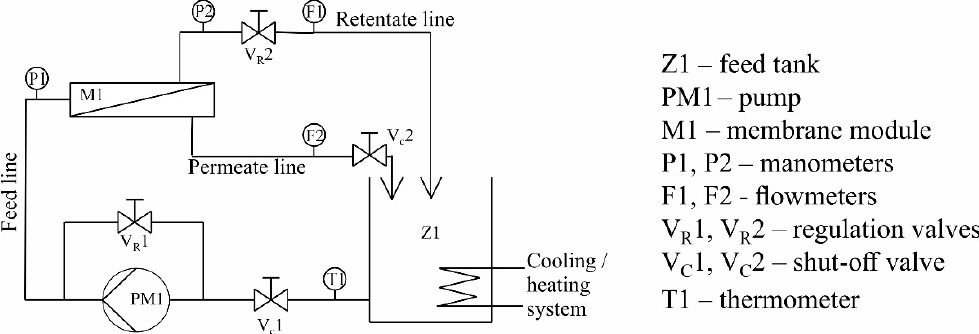
Figure 2. Installation scheme for microfiltration.